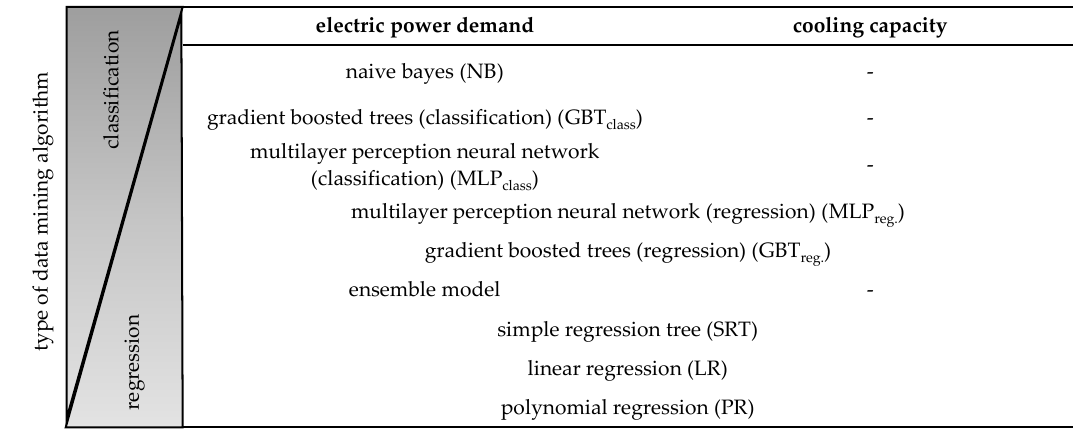
Figure 4. Data mining algorithms selected for the case study.